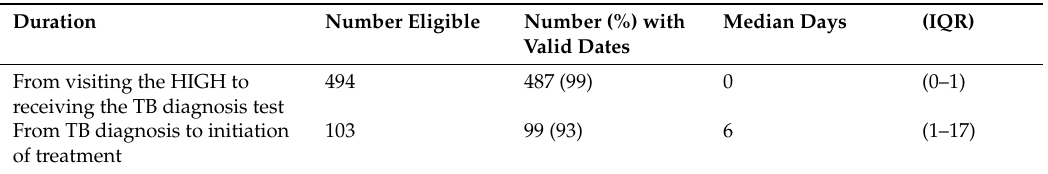
Table 5. Delays in the TB care cascade among the patients attending the Haiphong International General Hospital in Vietnam, from June to December